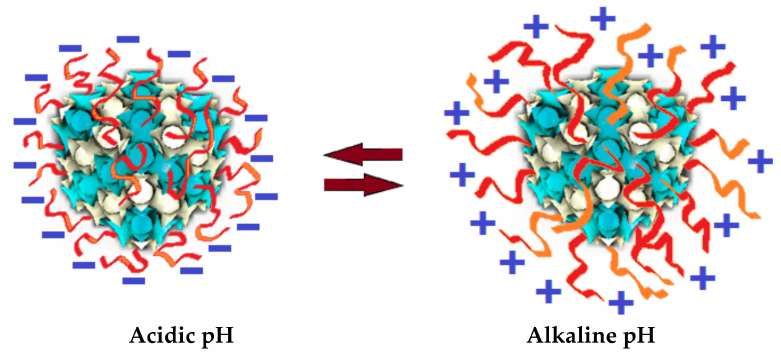
Figure7. Conceptofcompositepolyelectrolyte /